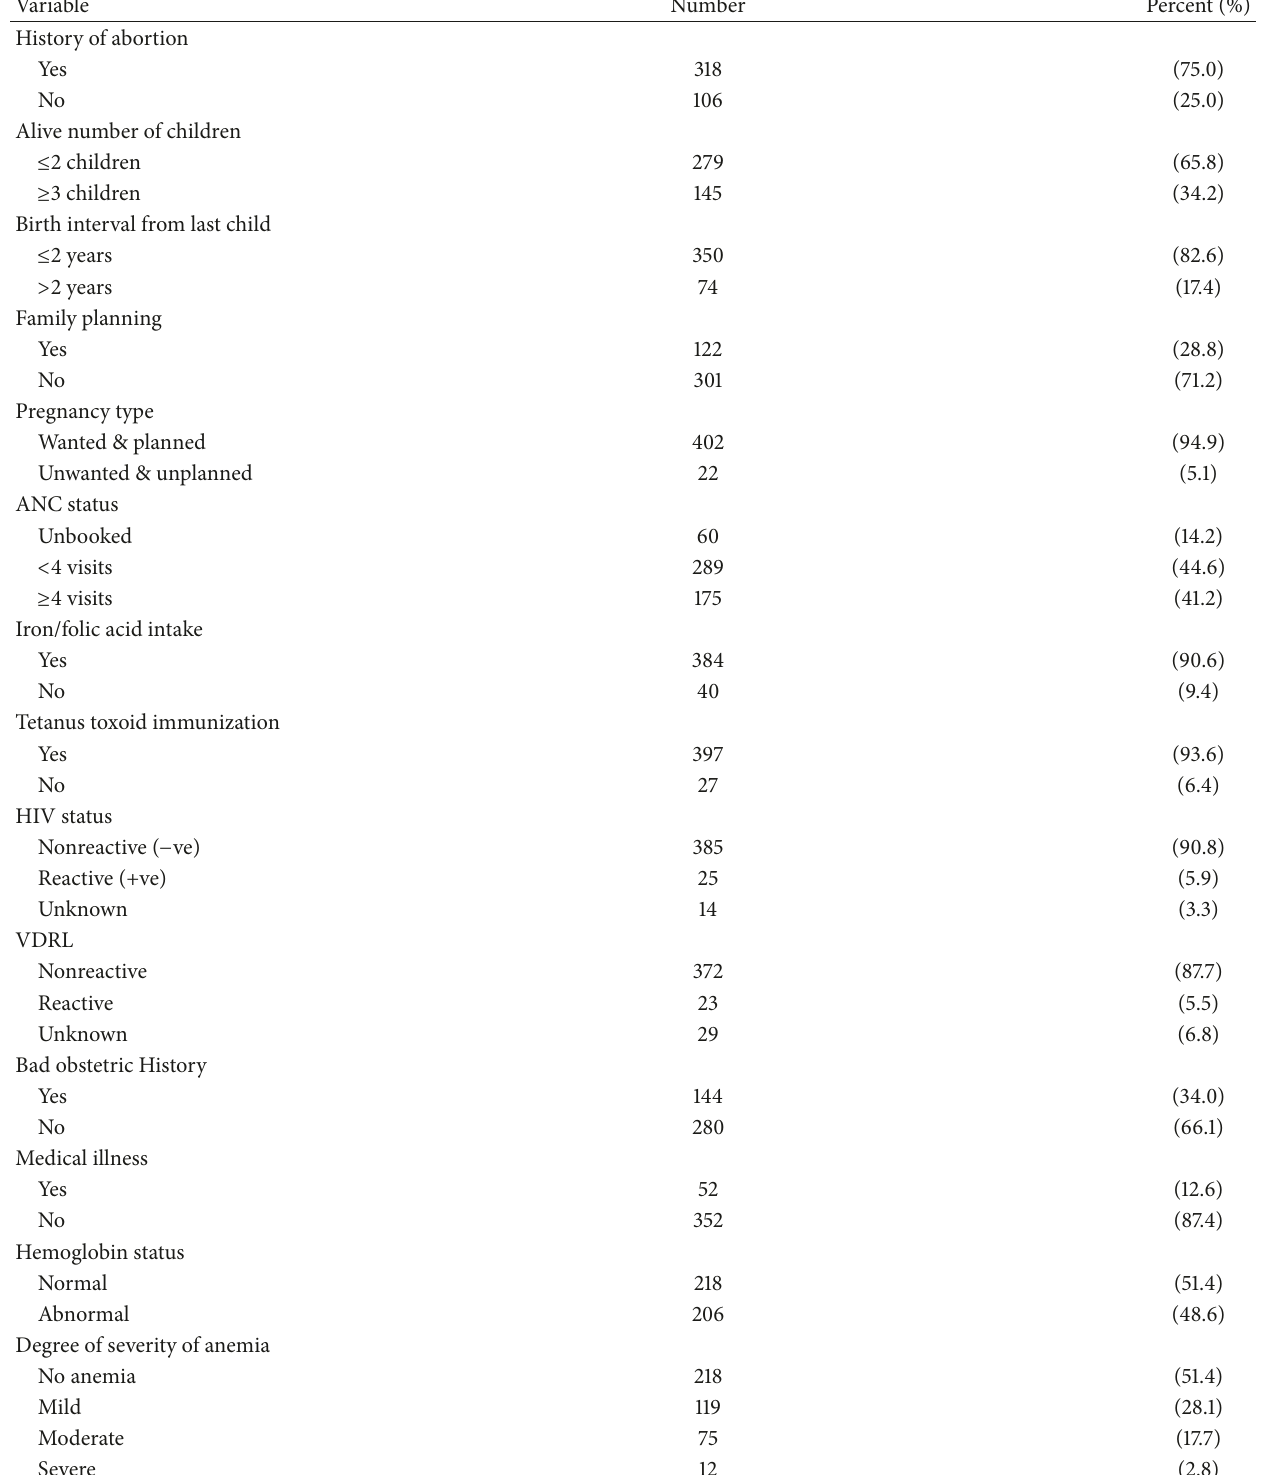
Table 2: Obstetric, medical, and health-related characteristics of the